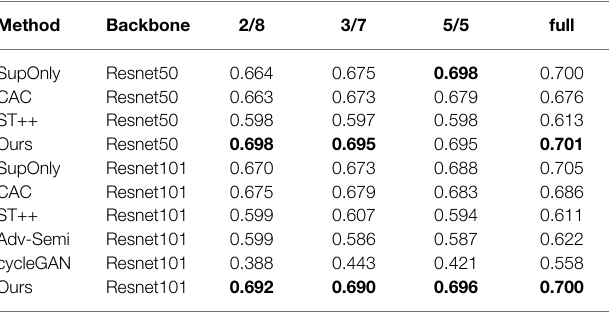
loss) and other state-of-the-art on WeedMap dataset with 2/8, 3/7, 5/5, and full labelled